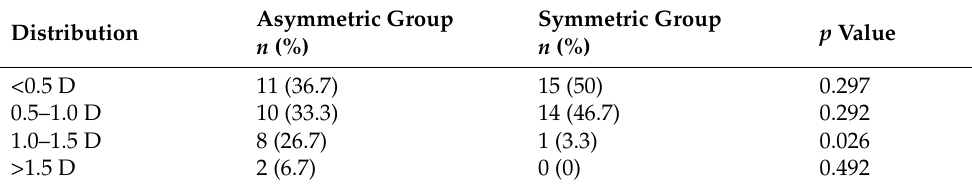
Figure 2. Double-angle plots of residual astigmatic refractive errors in the asymmetric and symmetric bowtie astigmatism groups. ( A ) asymmetric bowtie astigmatism group; ( B ) symmetric bowtie astigmatism group; The centroid (red plot) is the arithmetic mean of astigmatism of individual cases (blue plot). The centroid residual astigmatic refractive errors were 0.53 D@175° and 0.31 D@173° in the asymmetric and symmetric groups, respectively. The asymmetric group included more eyes with a residual astigmatic refractive error of >1.0 D. Table 2. Comparison of the distribution of residual astigmatic refractive errors between asymmetric and symmetric bowtie corneal astigmatism groups.